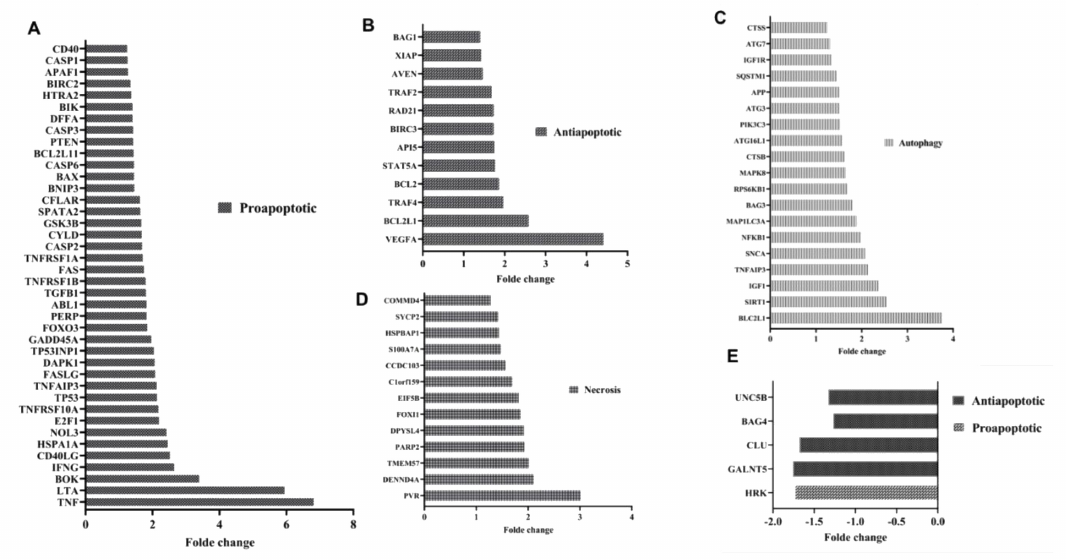
Figure 4. miR-21 induces cell death in T lymphocytes. ( A ) T cell lentivirus transduction e ffi ciency: analysis using cytometry of the percentage of transduced human T lymphocytes ( = 3) by lentiviral vectors containing GFP and hsa-miR-21 or scramble as a control ( = 3). ( B ) Relative expression of miR-21 in lenti-miR-21-transduced cells ( = 3) compared to the control ( = 3). ( C ) MiR-21 induces HD T lymphocyte cell death. ( D ) Inhibition of miR-21 expression increases resistance to cell death in T lymphocytes ( = 3). All data were collected and statistically analyzed using Student’s t -test. Values are presented as the means of at least three independent experiments. The levels of statistical significance were set at p ≤ 0.03 and p < 0.01.